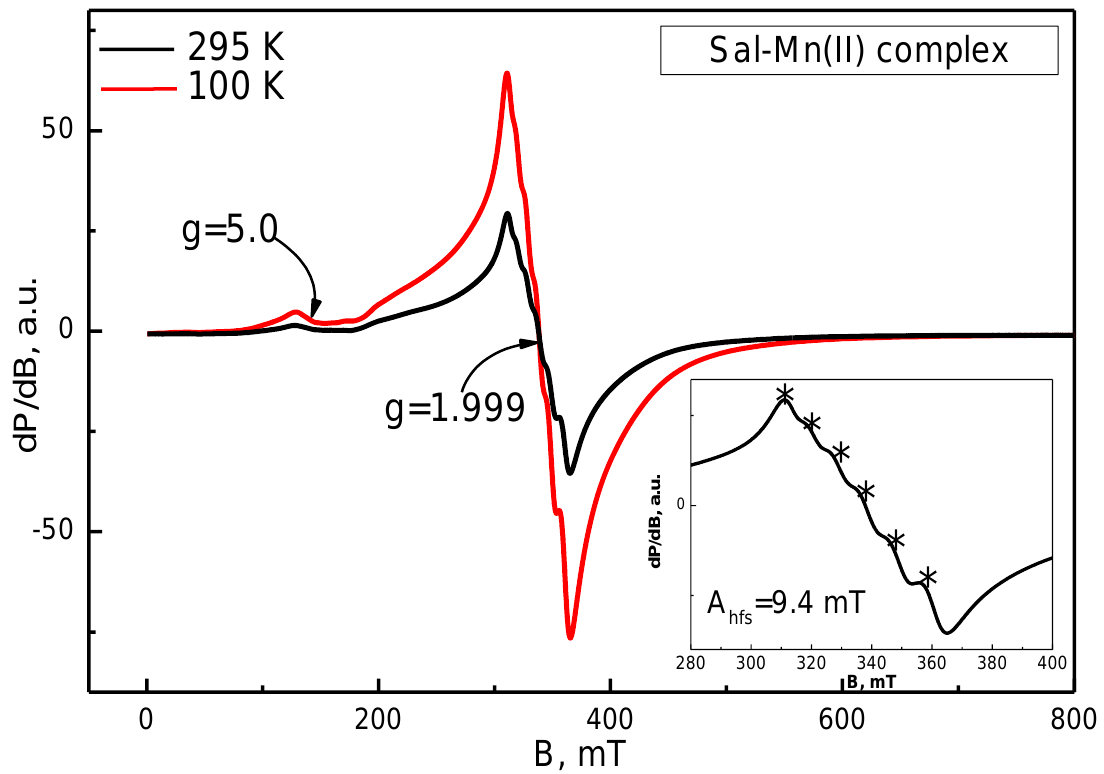
Figure 2. EPR spectra of Sal-Mn(II) complex at 295 and 100 K. The six lines of the Mn 2+ hyperfine structure are shown in the inset.